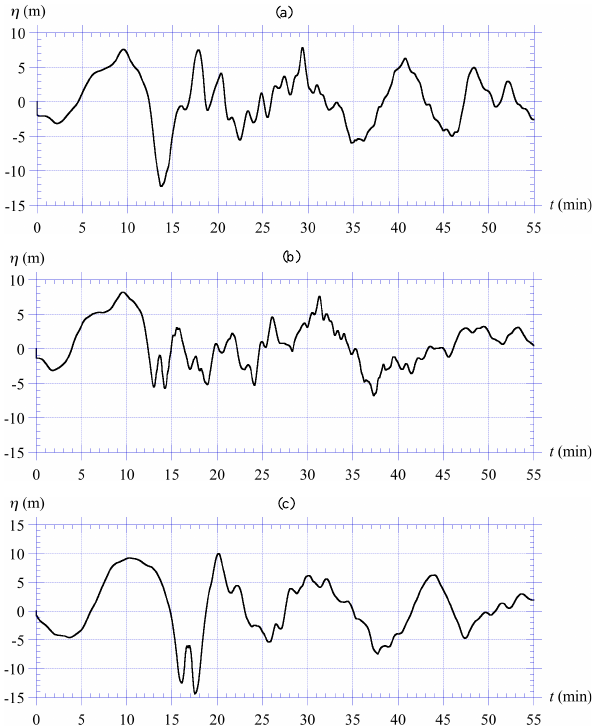
Fig. 11. Same simulations as in Figs. 6 and 7 (fine grid). Time series of surface elevation at locations 1–3 marked in Fig. 5, along PRNS. Depth at gages is: (a) 51.2; (b) 10.2; and (c) 22.7m from MWL. [Time is with respect to fine grid simulations (i.e., starting at 350s).]